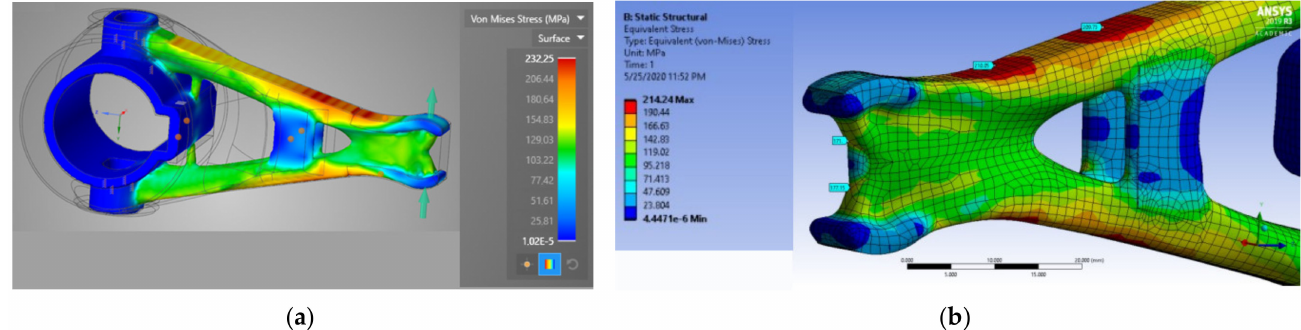
Figure 6. Results of the simulations using a topologically smoothed shifting thumb in the form of von Mises stress contours: ANSYS Discovery Live ( a ) and ANSYS Workbench ( b